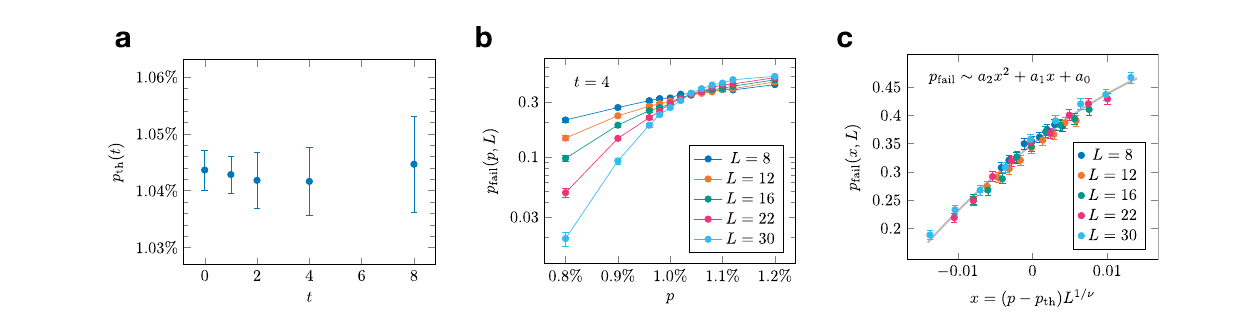
Fig.8|Numericalestimatesofthesingle-shotMWPMdecoderthresholdforthe 3D STC on L * cub . a The threshold p th ( t ) does not change noticeably with the number of correction cycles t . We estimate the storage threshold p STC ≈ 1.045%. b Thefailureprobability p fail ( p , D )after t =4correctioncycles,where p isthebit- fl ip